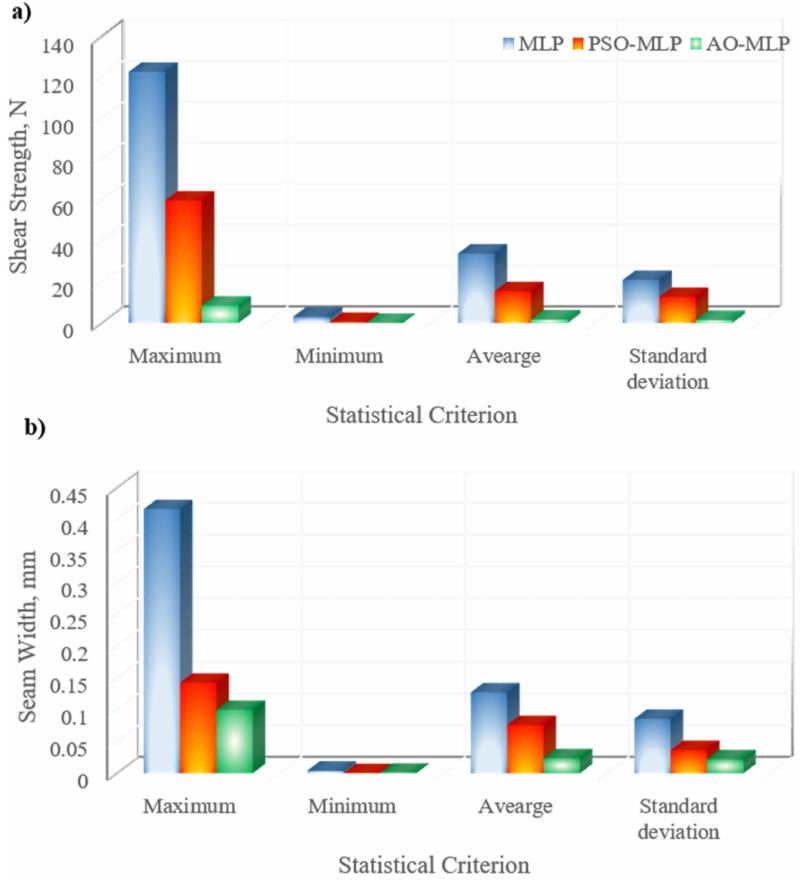
Figure 3. Maximum, minimum, average, and standard deviation of absolute errors between predicted data using MLP, PSO-MLP, and AO-MLP and target ones for: ( a ) shear strength and ( b ) seam